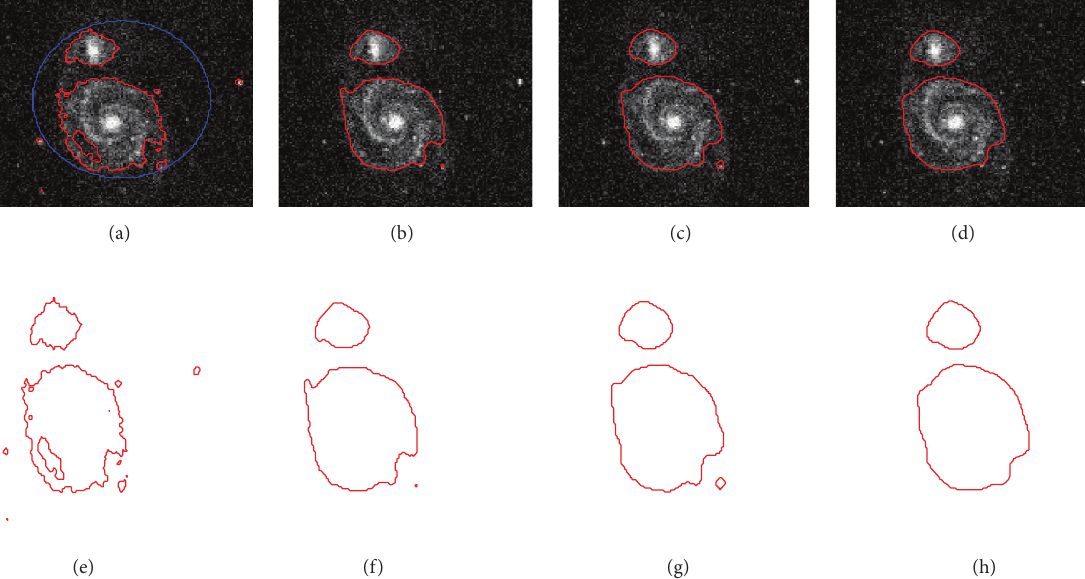
Figure 3: Segmental results of a galaxy image with Gaussian variance 0.05. (a) Segmental result with CV model and the blue curve is the initial contour ( 𝜇 0 = 0.03∗255∗255 ). (b) Segmental result with TV-based segmentation model. (c) Segmental result with adaptive TV-based model. (d) Anisotropic diffusion-based segmentation model. (e), (f), (g), and (h) are the corresponding contours to (a), (b), (c), and (d), respectively.